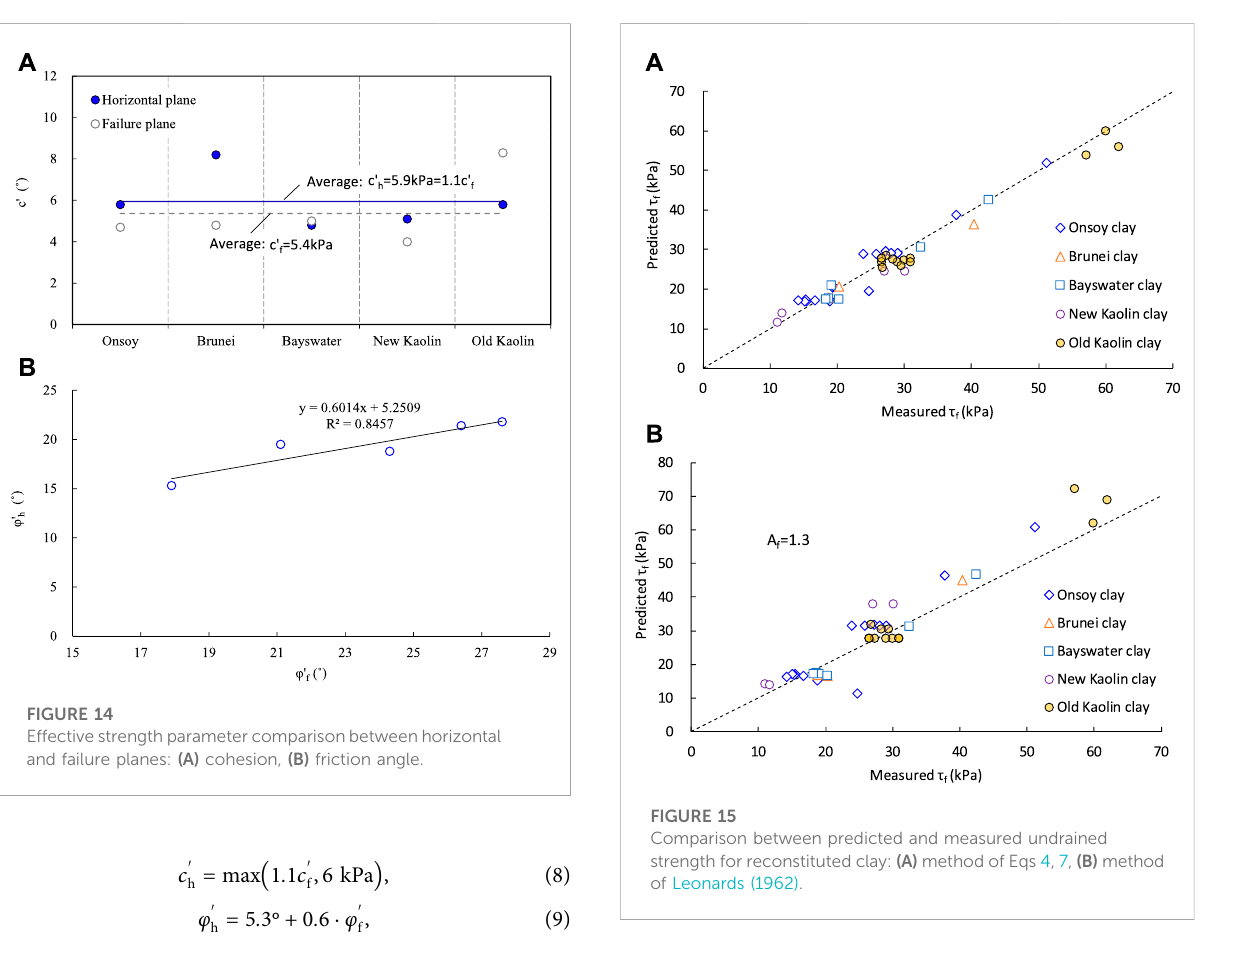
FIGURE 14 Effectivestrengthparametercomparisonbetweenhorizontal and failure planes: (A) cohesion, (B) friction angle.